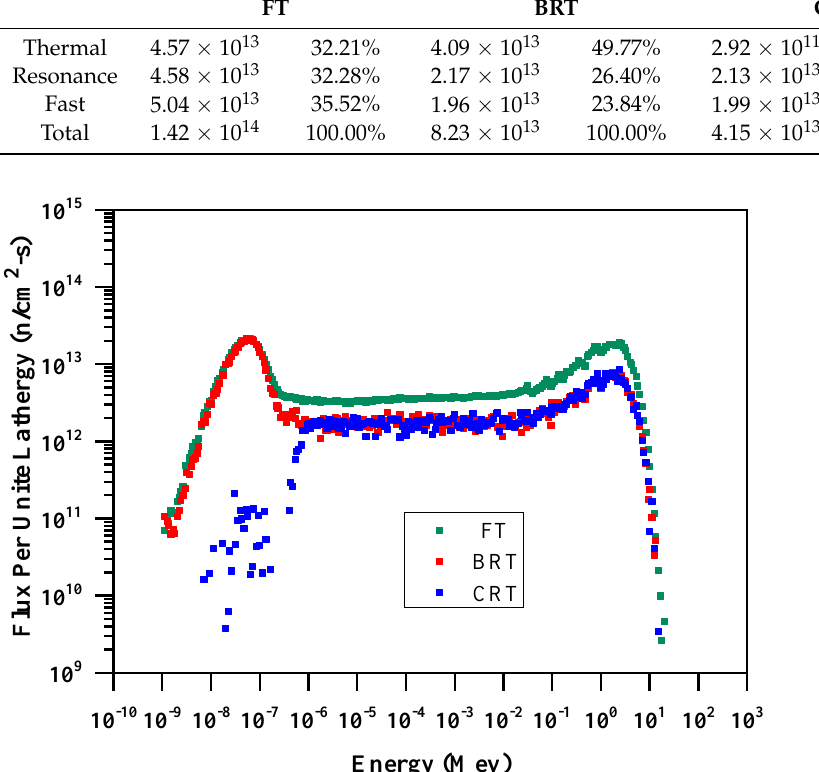
Figure 10. Neutron flux spectrum in-core irradiation facilities for the proposed MSTR-HPC. Table 4. Neutron Flux Spectrum In-Core Irradiation Facilities for MSTR-HPC.